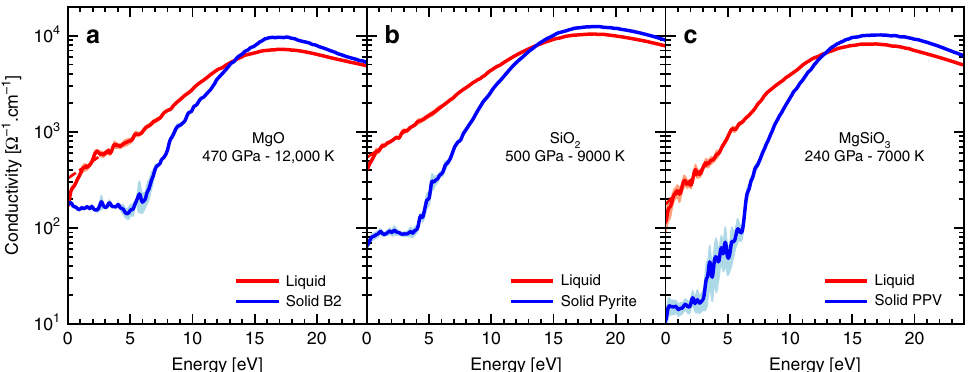
Fig. 3 Electric conductivity. The liquid (red) and the solid (blue) electric conductivities as a function of the excitation energy are plotted for a MgO, b SiO 2 , and c MgSiO 3 . The conditions are the same as those of Fig. 2. The shaded region is an indication of the one-sigma statistical uncertainty. We plotted in dashed lines the extrapolation of the conductivity in the liquid phase towards the direct current (DC) value (see the Methods